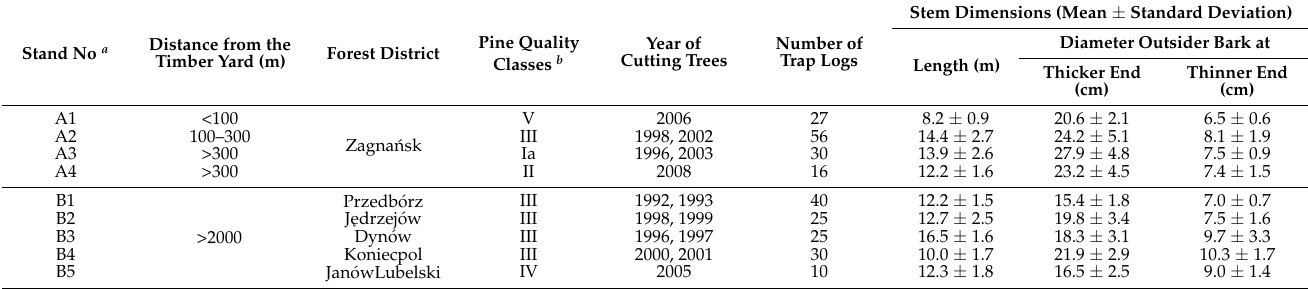
Table 1. Locality and stand data.